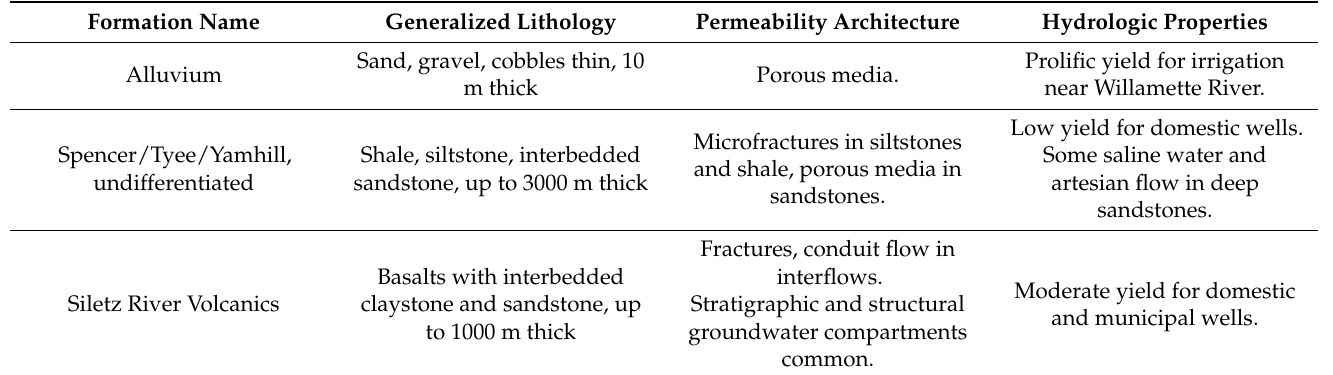
Table 1. Lithology, permeability, and hydrologic features of the various geologic formations at